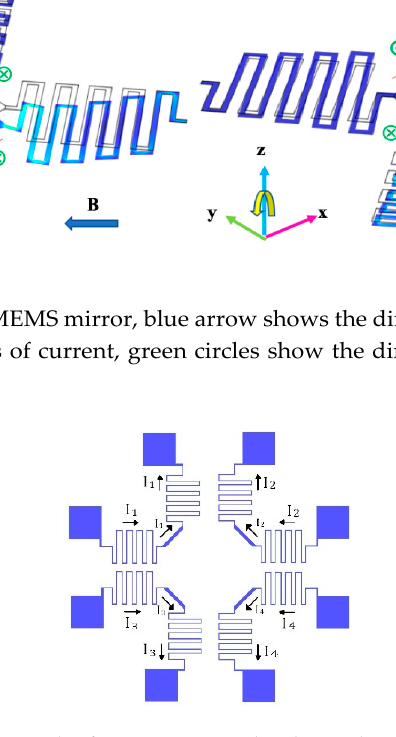
Figure 2. The four current paths showed